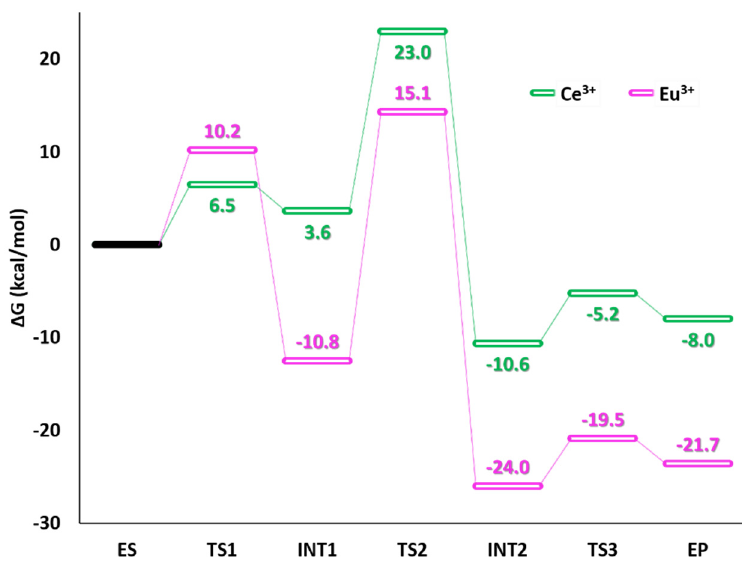
Figure 4. C-PCM( ε = 4) / B3LYP-D3 / 6-311 + G(2d,2p) | SDD calculated energy profiles for Ce 3 + -MDH [105] and Eu 3 + -MDH [106].